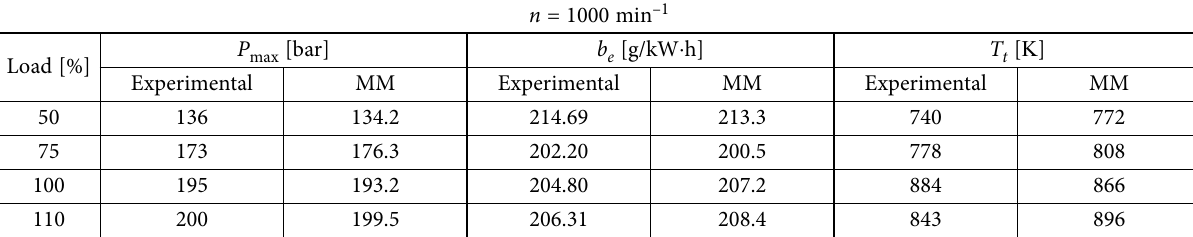
Table A4. Comparison of diesel engine ChN 26.5/31 MM adequacy validation experiment and modelling results n = 1000 min –1